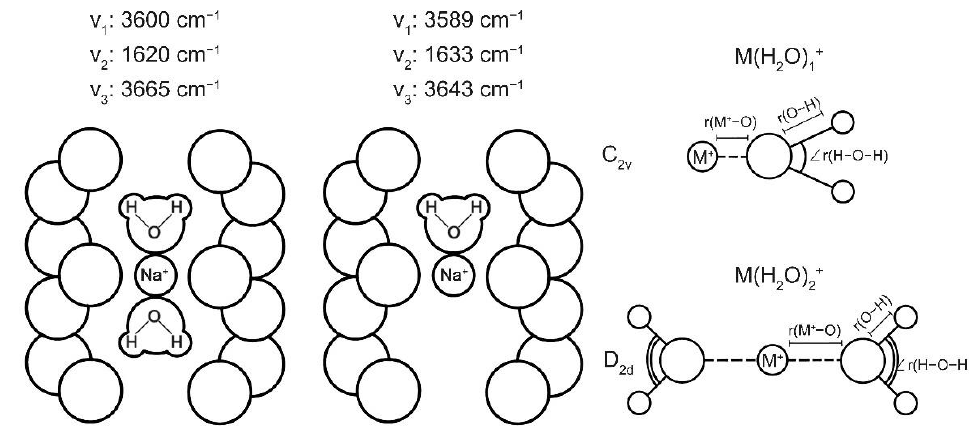
Figure 5. Schematic diagram of type II water in water-rich and water-poor condition (from G. Della Ventura [20], redrawn).